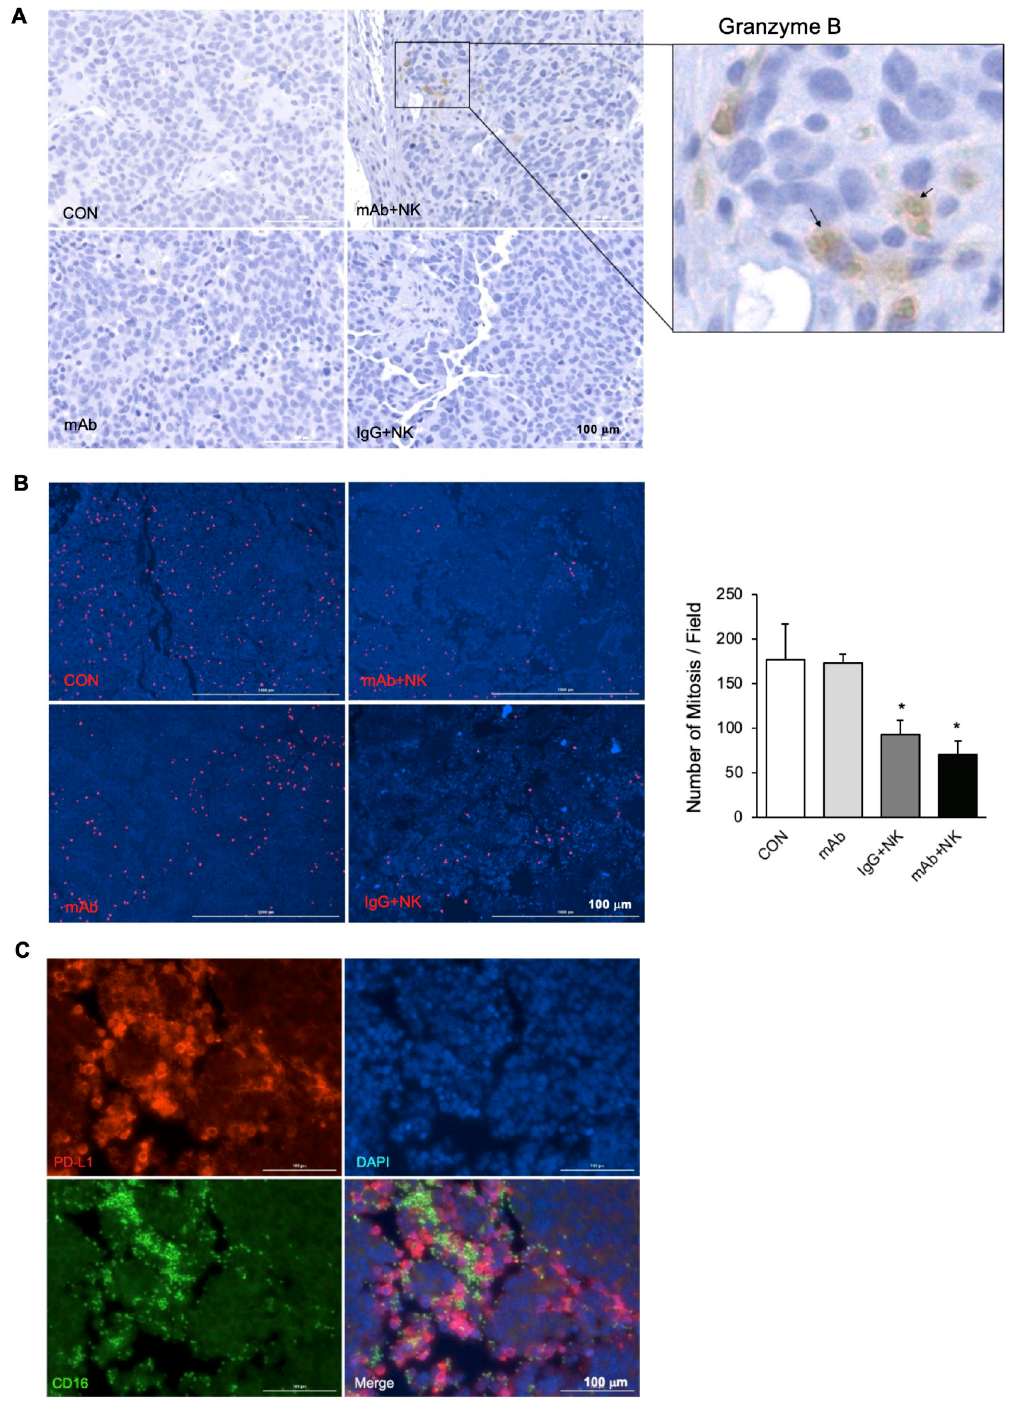
Fig 6. GRP-R mAb-mediated ADCC in mouse xenograft tumors. (A) Granzyme B was detected by immunohistochemical staining with Granzyme B antibody in paraffin-embedded sections of BE(2)-C xenografts. (B) Immunofluorescence double staining of Phospho-Histone H3 (red) in the mitotic tumor cells and DAPI on nuclei DNA in all cells (blue) was performed in paraffin-embedded sections of tumor xenografts (left). Mitotic cells were quantified by counting positive immunofluorescent stained phospho-Histone H3 (ser10) cells (right). (C) Immunofluorescence triple staining of PD-L1 on the membrane of tumor cells (red) and CD16-FITC on NK cells (green) in tumor tissue sections. DAPI was used for counterstaining nuclei DNA in all cells. Scale bar: 100 mm. Data represent mean ± STDEV; � = p < 0.05 vs. CON.